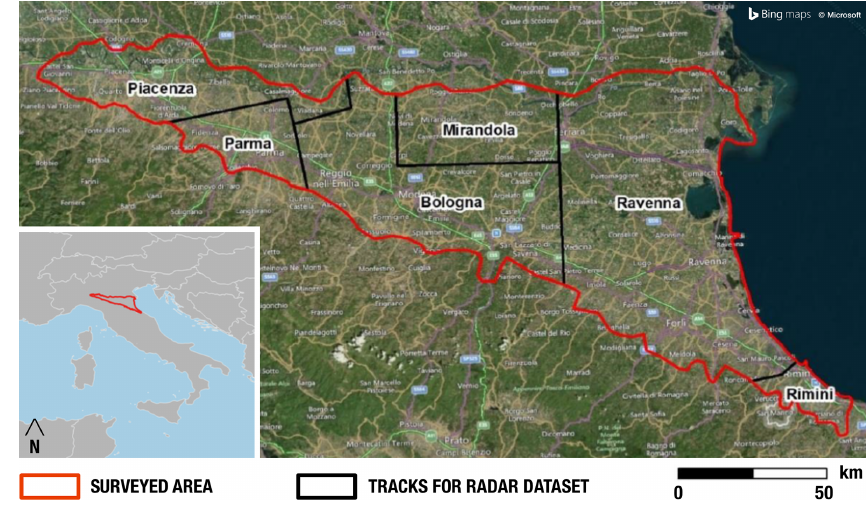
Figure 2. The area covered by the 6 tracks of processed radar data.